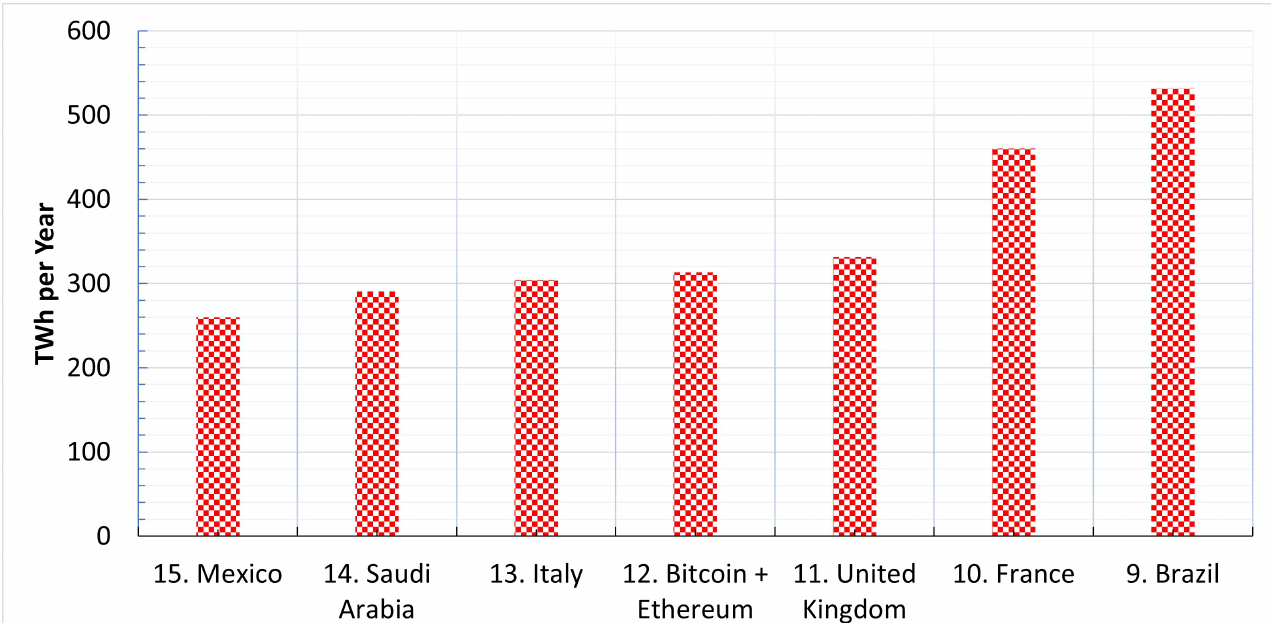
Figure 9. Energy consumption by country including Bitcoin and Ethereum (energy consumption of each country according to International Energy Agency and Bitcoin energy index is adopted from https://digiconomist.net, accessed on 1 January 2022).